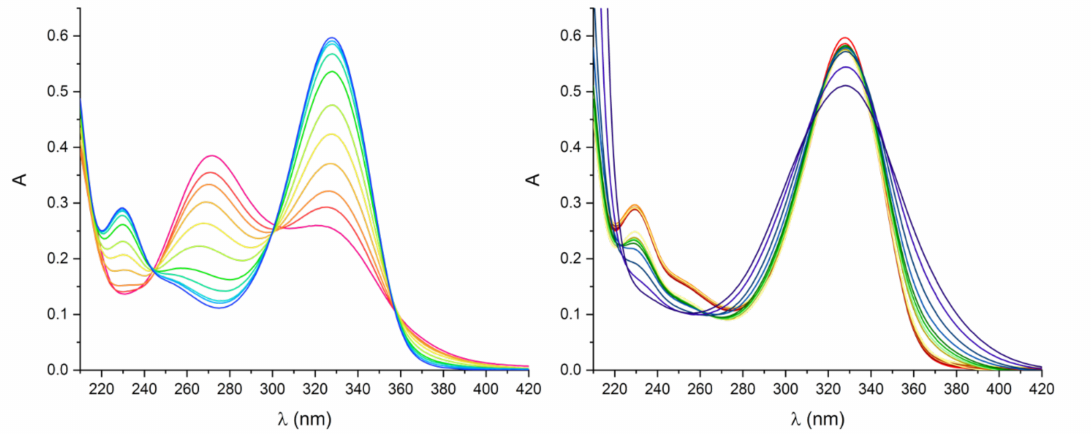
Figure 2. Acidic ( left ) (pink pH 0.83 to blue pH 4.2) and alkaline ( right ) (pink pH 4.2 to violet pH 12.3, first di ff ering spectrum pH 9.1) branches of H 3 L UV-Vis absorption spectra ([H 3 L] = 1.2 × 10 − 5